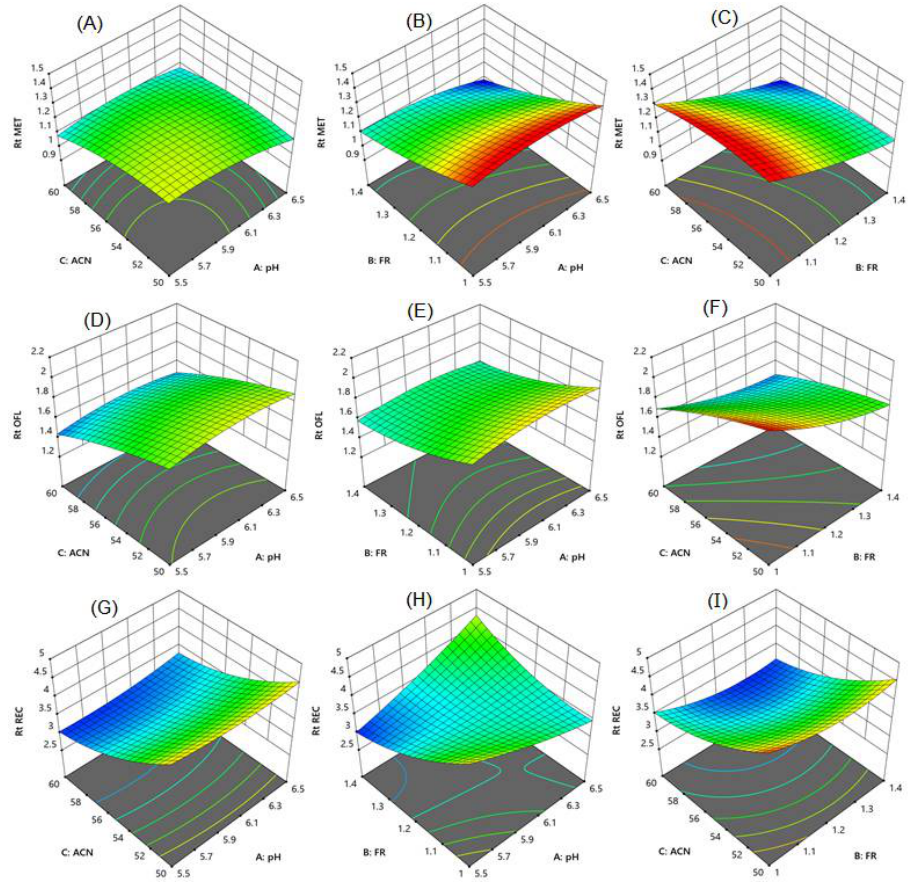
Figure 3. Response surface graphs for ( A – C ) metronidazole, ( D – F ) ofloxacin, and ( G – I ) racecadotril. Chromatographic parameters pH (5.5, 6, and 6.5), flow rate (1.0, 1.2, and 1.4 mL/min) and concen- tration of acetonitrile (50, 55, and 60%).